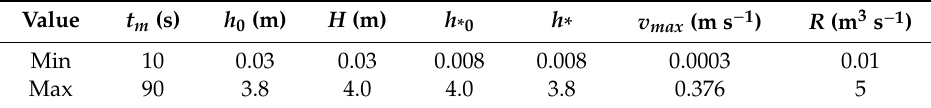
Table 2. Minimum (Min) and maximum (Max) values of the hydraulic. parameters assumed for the water tank.